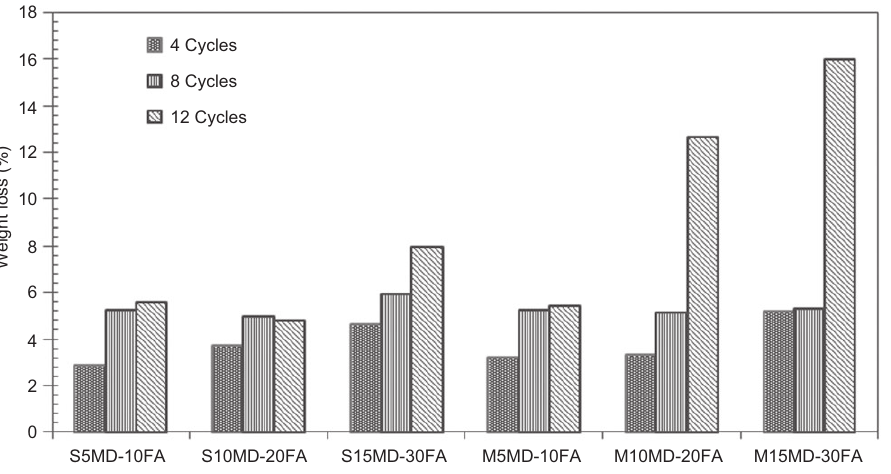
Figure 7 Weight loss after freezing-thawing.